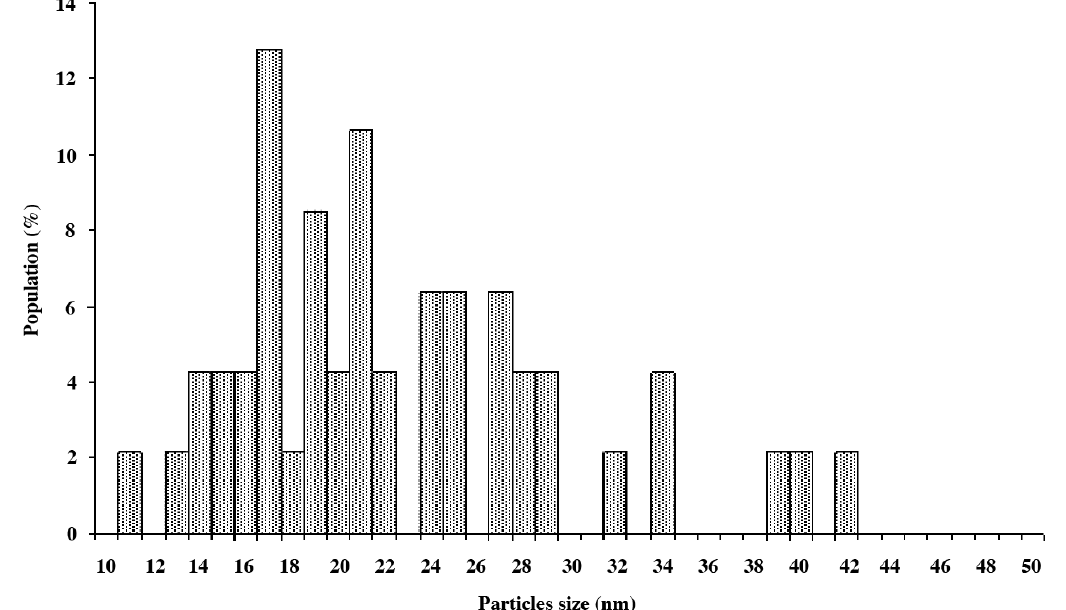
Figure 2. Aeroxide ® TiO P25 nanoparticles size distribution from TEM 2